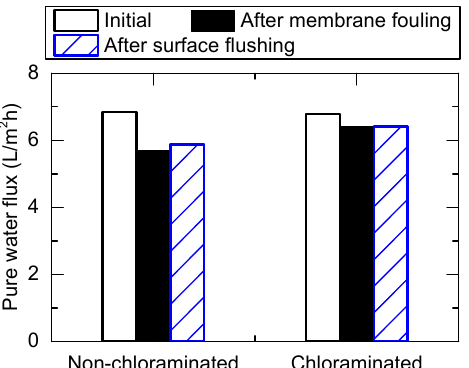
Figure 10. Pure water flux before and after membrane fouling, and surface flushing at the second test using primary wastewater effluent.